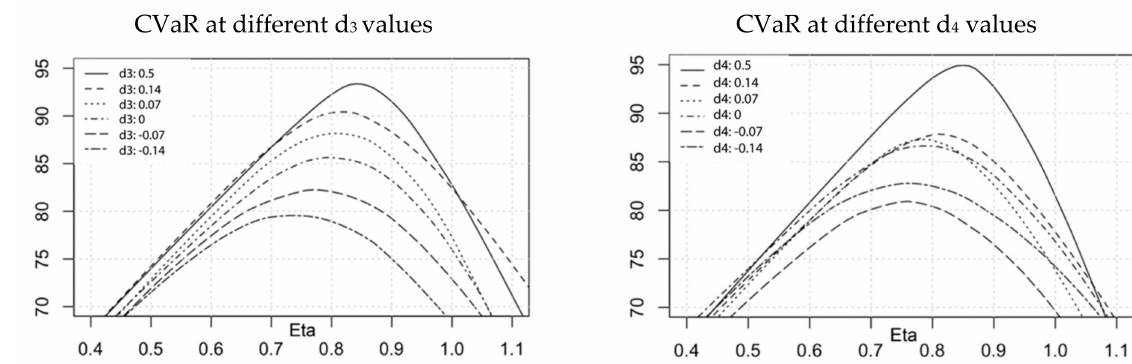
Figure 9. Sensitivity of the CVaR to different SNP parameters. Sensitivity of the conditional value-at-risk (CVaR) to skewness ( d 3 ) and kurtosis ( d 4 ) parameters. The y axis in both graphs is measured in million Colombian pesos